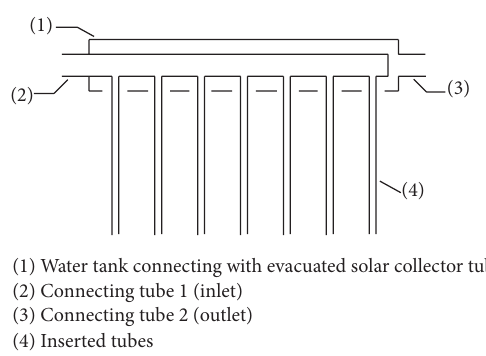
Figure1:Schematicdiagramofanovelall-glassevacuatedtubesolar collector manifold header with inserted tubes.